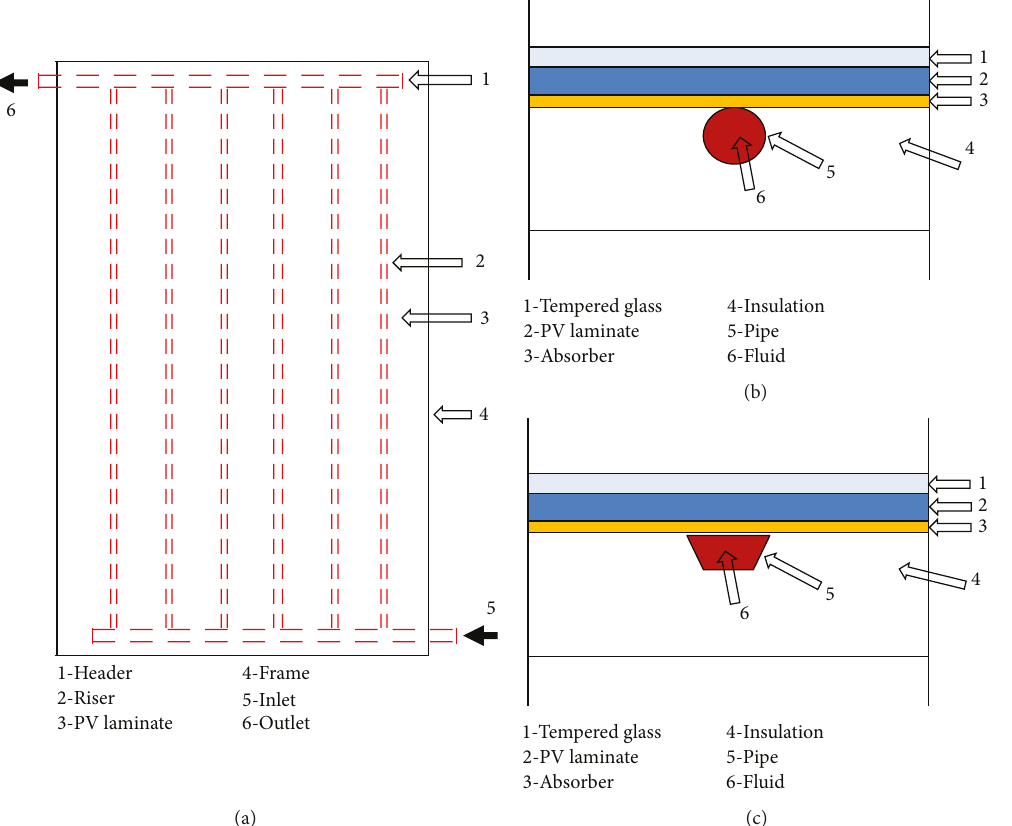
Figure 1: PV/T collector: (a) schematic details, (b) cross section with a circular receiver, and (c) cross section with a trapezoidal